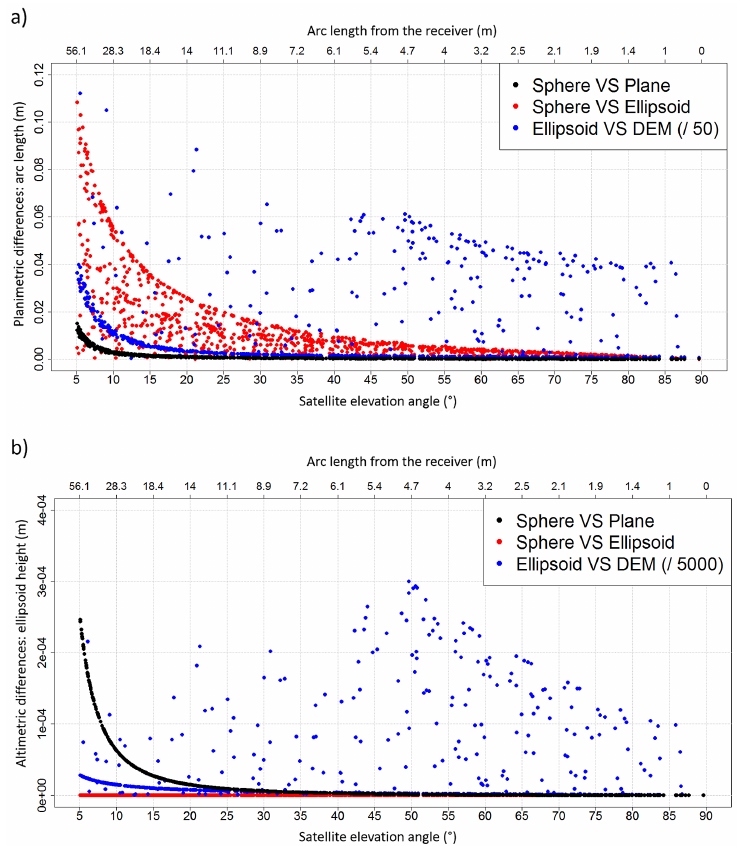
Figure 11. Planimetric and altimetric differences between the specular reflection points obtained with the different algorithms. Receiver height above the reflecting surface: 5m. (a) Planimetric differences as arc length (m). (b) Altimetric differences as ellipsoid height (m). Note the dispersion within results for a fixed elevation angle, which is a consequence of the azimuth variability in the ellipsoidal radius of